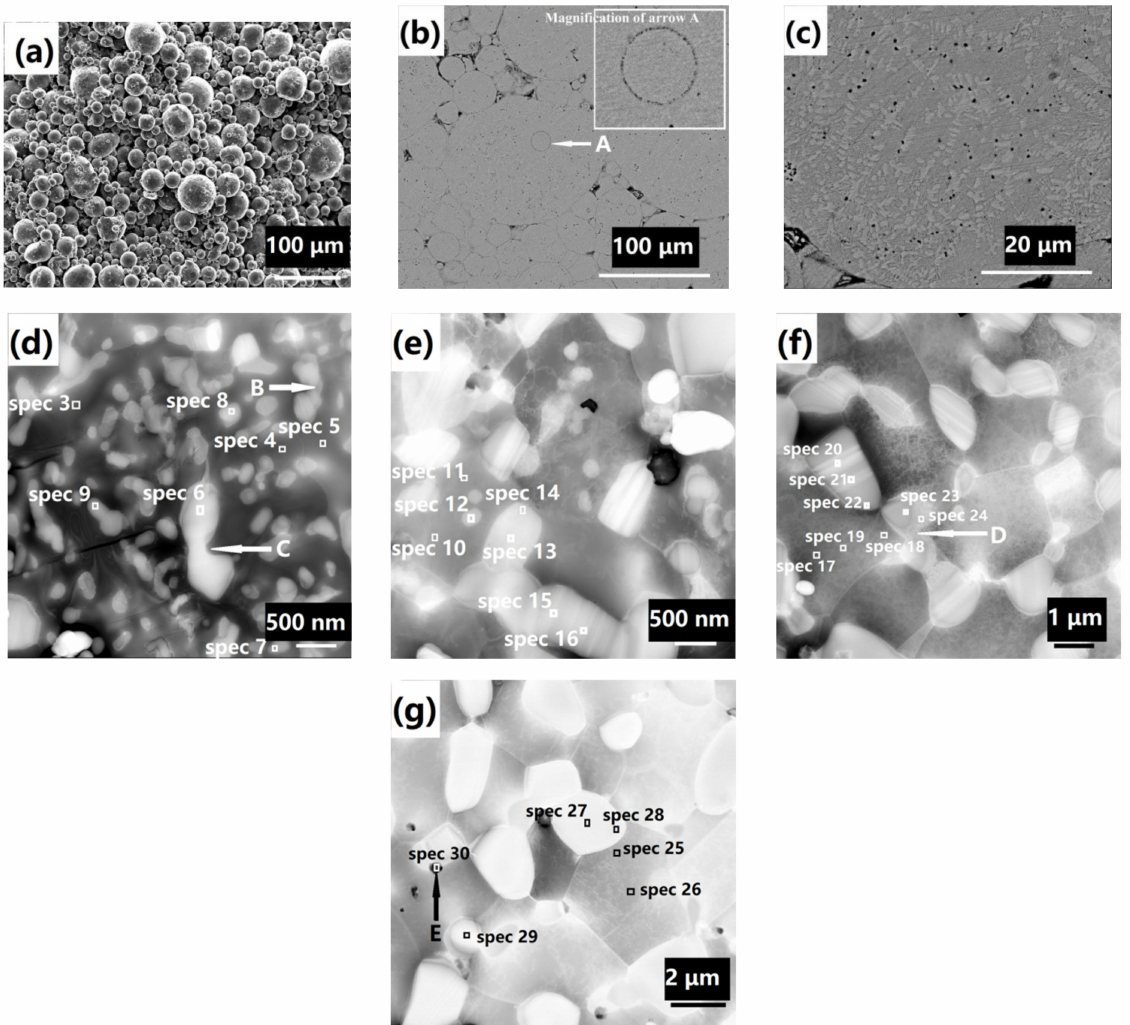
Figure 11. Microstructure and EDS (energy-dispersive spectroscopic) point analysis of BSS after HIP sintering at six temperatures: ( a ) 600 ◦ C, ( b ) 700 ◦ C, ( c ) 700 ◦ C, ( d ) 900 ◦ C, ( e ) 1000 ◦ C, ( f ) 1100 ◦ C, and ( g ) 1160 ◦